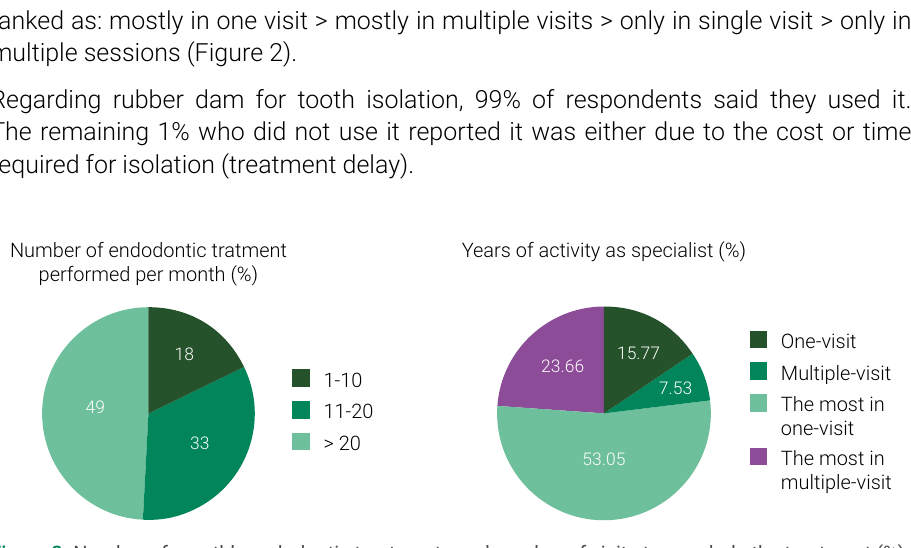
Figure 2. Number of monthly endodontic treatments and number of visits to conclude the treatment (%).